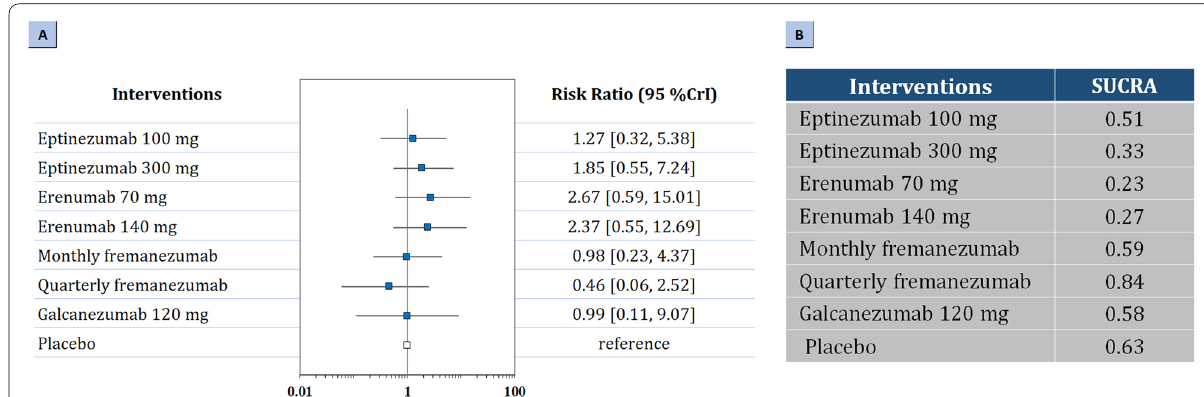
Fig. 4 Summary of the secondary safety outcomes. Network plot of ( A ) The forest plot for serious adverse events; ( B ) The SUCRA value of each treatment for serious adverse events. SUCRA: surface under the cumulative ranking